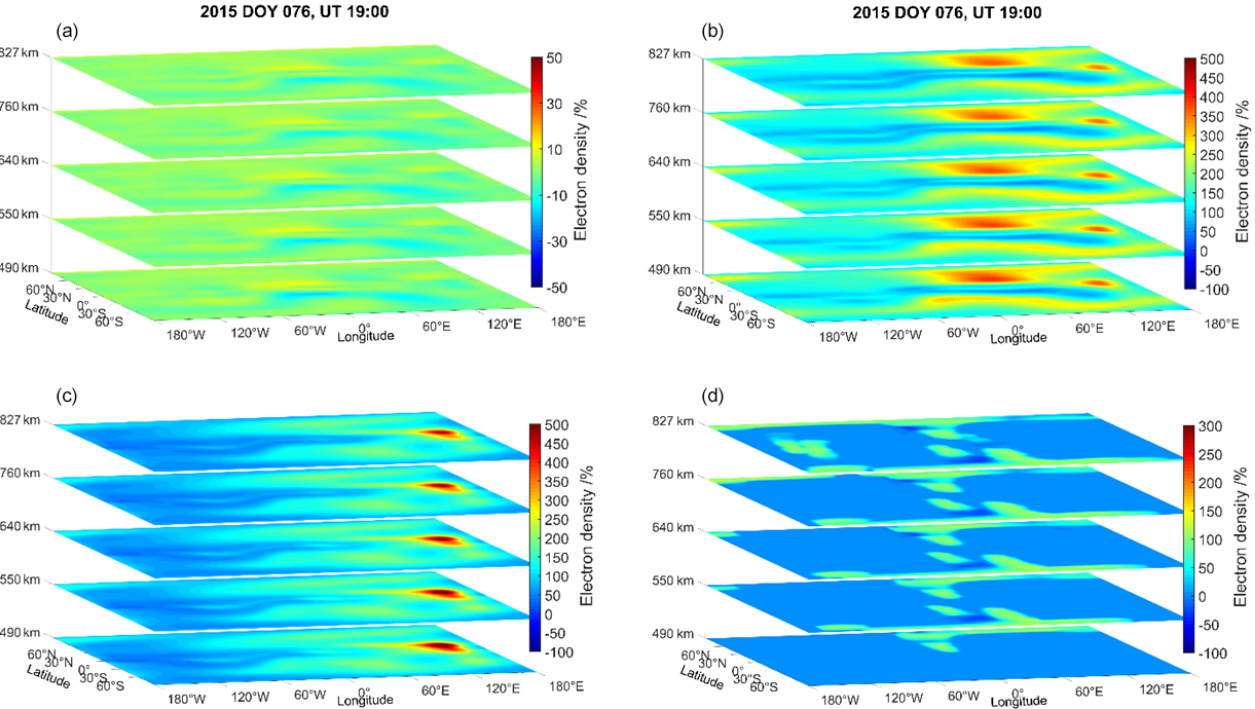
Figure 5. Differences between reconstructed and NeQuick-modelled electron density in percent, represented by layers at different heights between 490 and 827km. (a) Rotation with exponential decay. (b) Rotation. (c) Exponential decay. (d) SMART + .